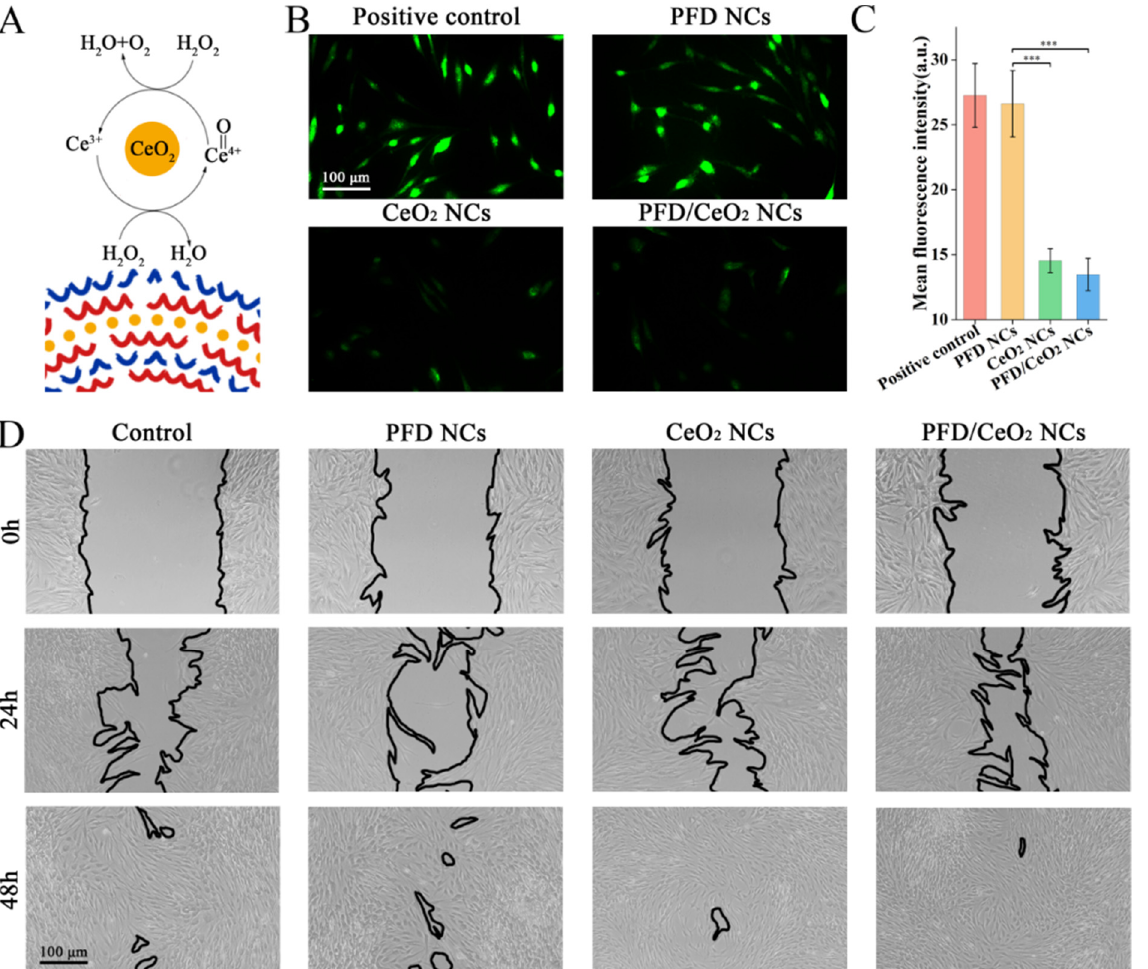
Figure 4. ( A ) Schematic of catalase-like activity of CeO 2 ; ( B ) Fluorescence micrographs of ROS assay in each group; ( C ) Mean fluorescence intensity of ROS assay in each group; ( D ) Optical micrographs of scratch assay in each group at 0 h, 24 and 48 h. (***, p <